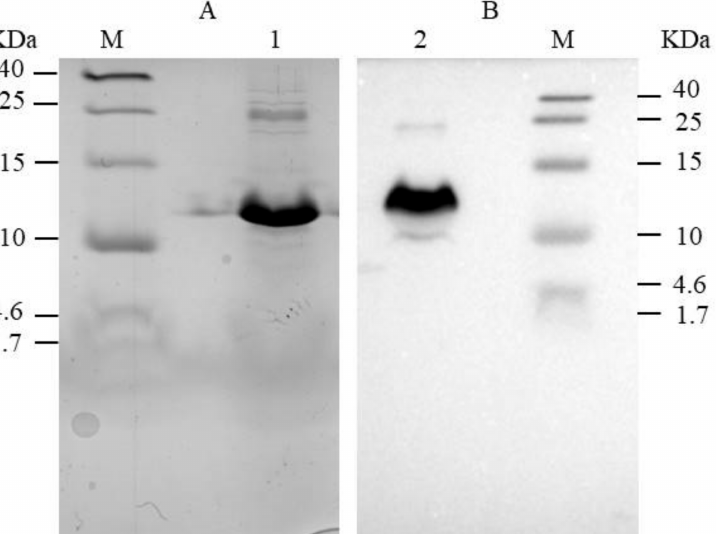
Figure 9. SDS-PAGE and western blotting analysis of fusion peptide CgR2150. ( A ) SDS-PAGE electrophoresis, ( B ) western blotting analysis. Lane M indicates pre-stained ultra-low molecular weight marker (1.7–40 kDa). Lanes 1 and 2 indicate the molecular weight of peptide CgR2150.